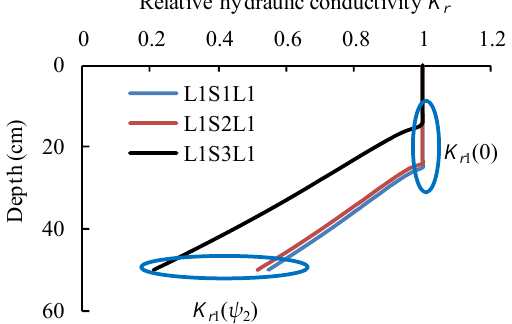
Figure 6. The distribution of relative hydraulic conductivity in the first layer when the buried depth of sand is 50 cm and the infiltration time is 300 min.